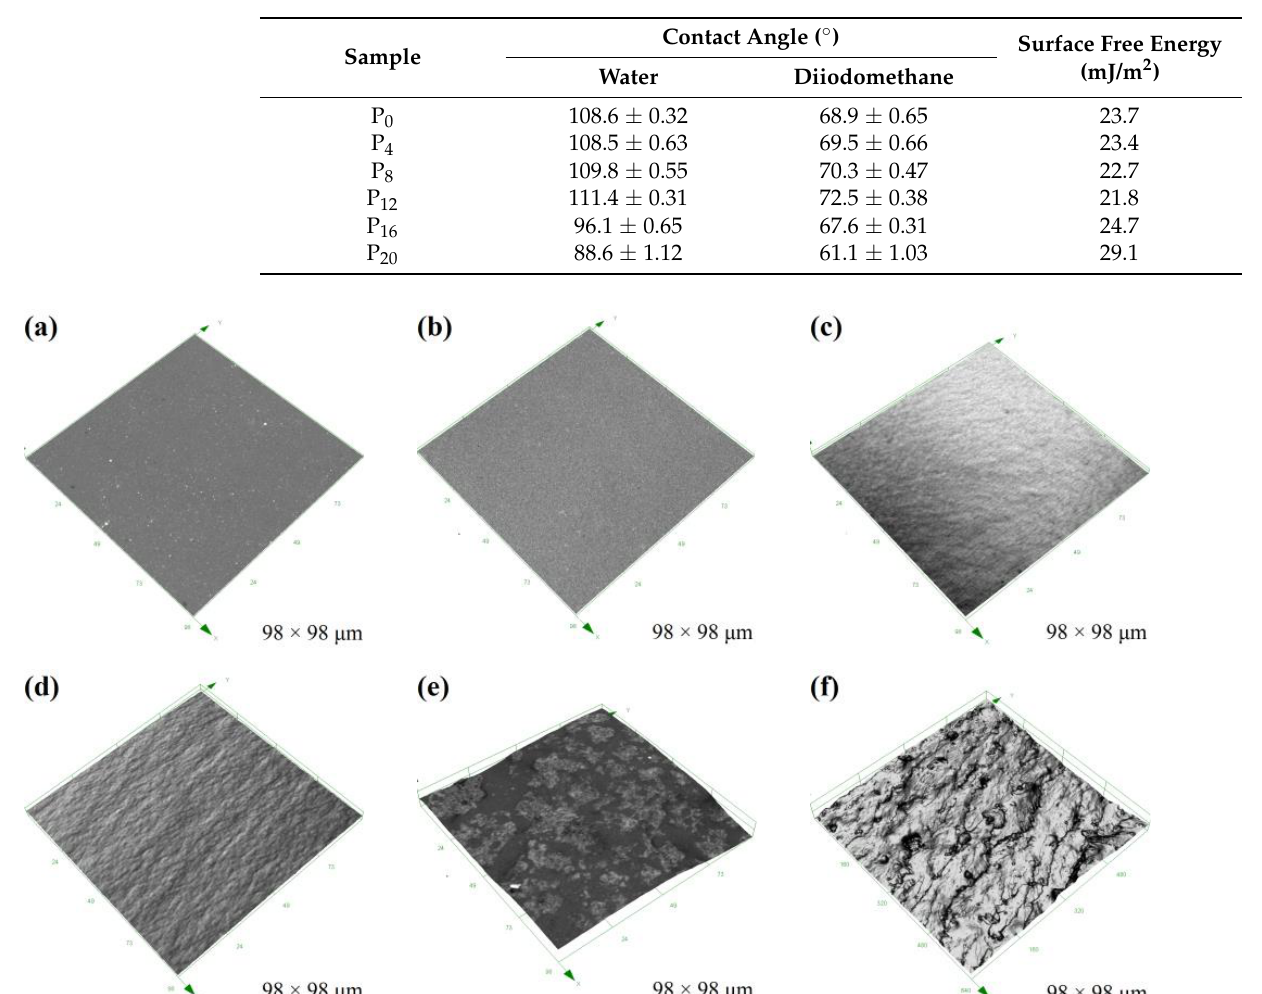
Table 1. The surface properties of the prepared coatings.